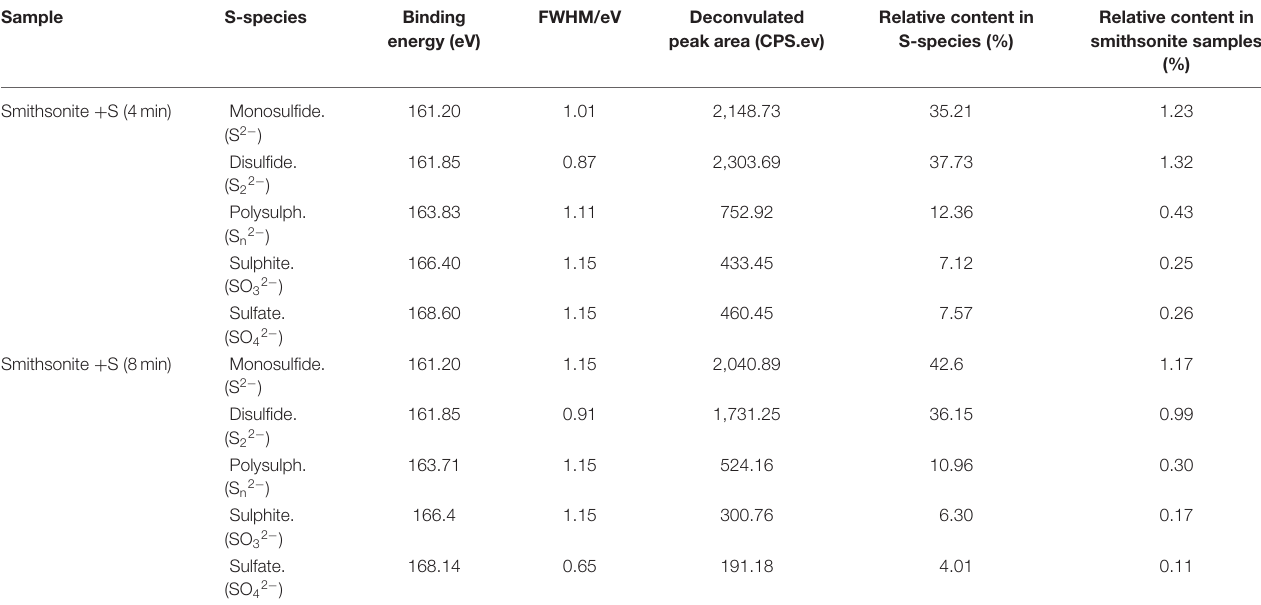
TABLE 3 | The S-species concentrations of smithsonite samples in different sulfurization